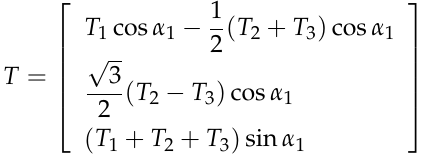
Figure 3. Torque distribution diagram of piezoelectric internal structure.